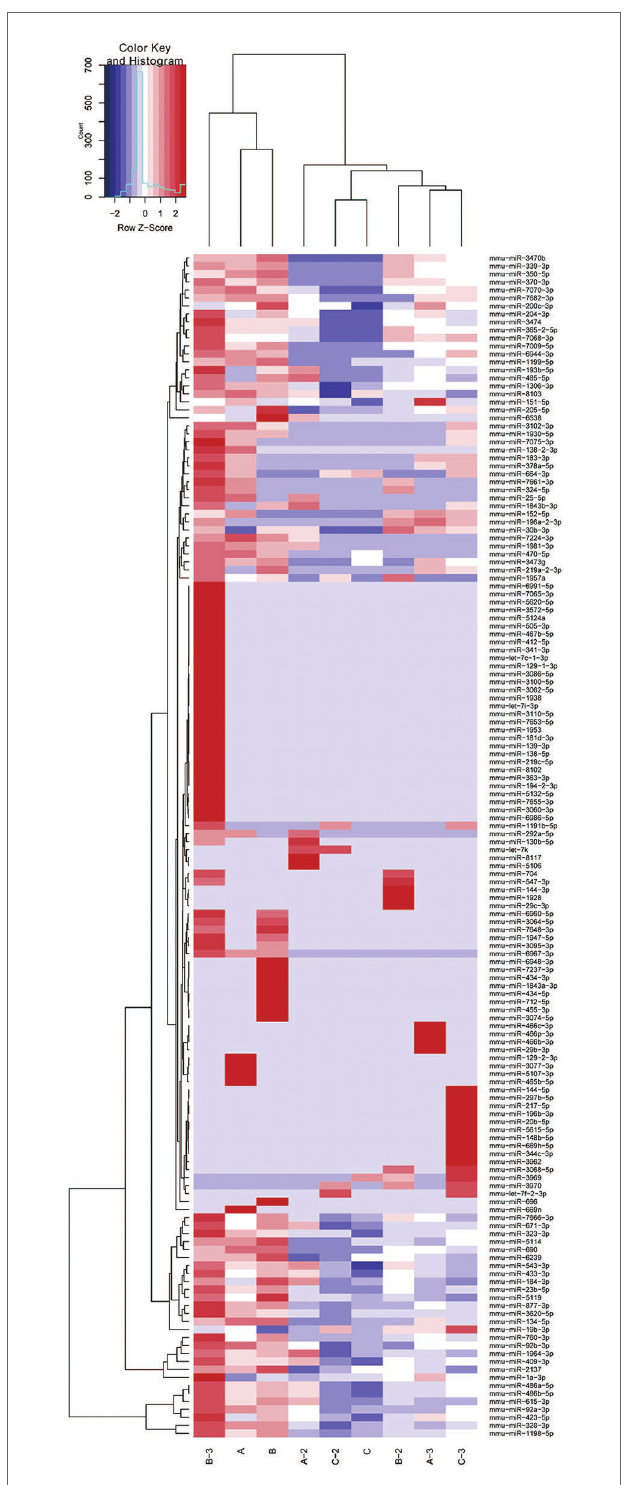
FIGURE 4 | Bidirectional hierarchical cluster result of the differentially expressed miRNAs in EVs derived from NG/MA/HG-treated podocytes ( n = 3 per group). High expression of miRNAs is shown in red and low expression in blue. A, NG-podo-EVs; B, MA-podo-EVs; C, HG-podo-EVs; HG, high glucose; MA, mannitol; NG, normal glucose.